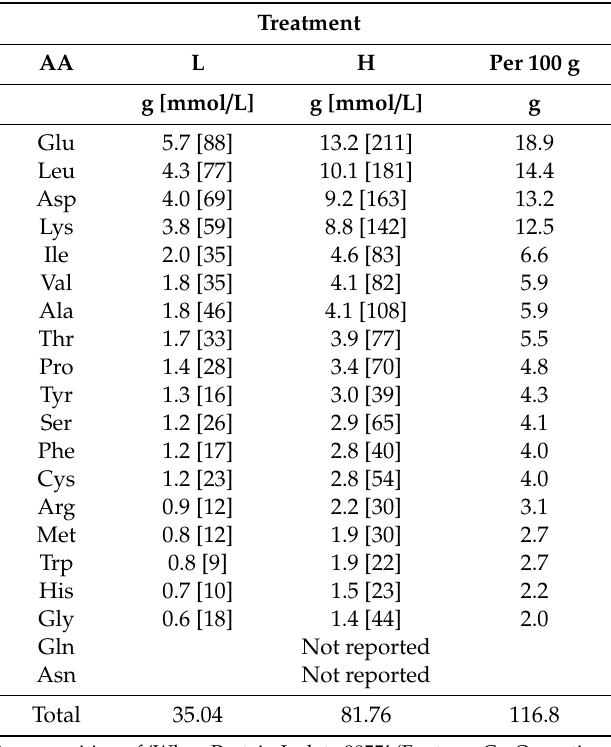
Table A1. Amino acid (AA) composition of test drinks containing 30 g (L) or 70 g (H) of pure whey protein isolate a,b